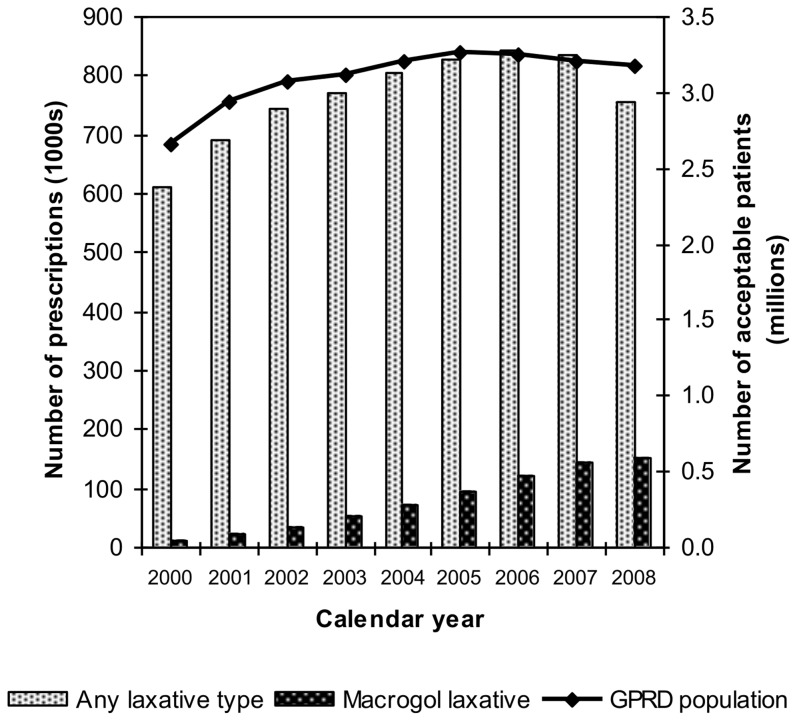
The number of all laxative prescriptions and macrogol laxative prescriptions on the GPRD by calendar year and the growth of the GPRD population.